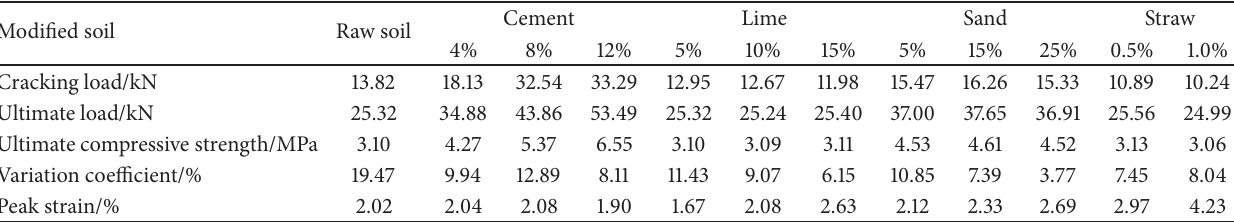
Table 3: Mean compressive strength and peak